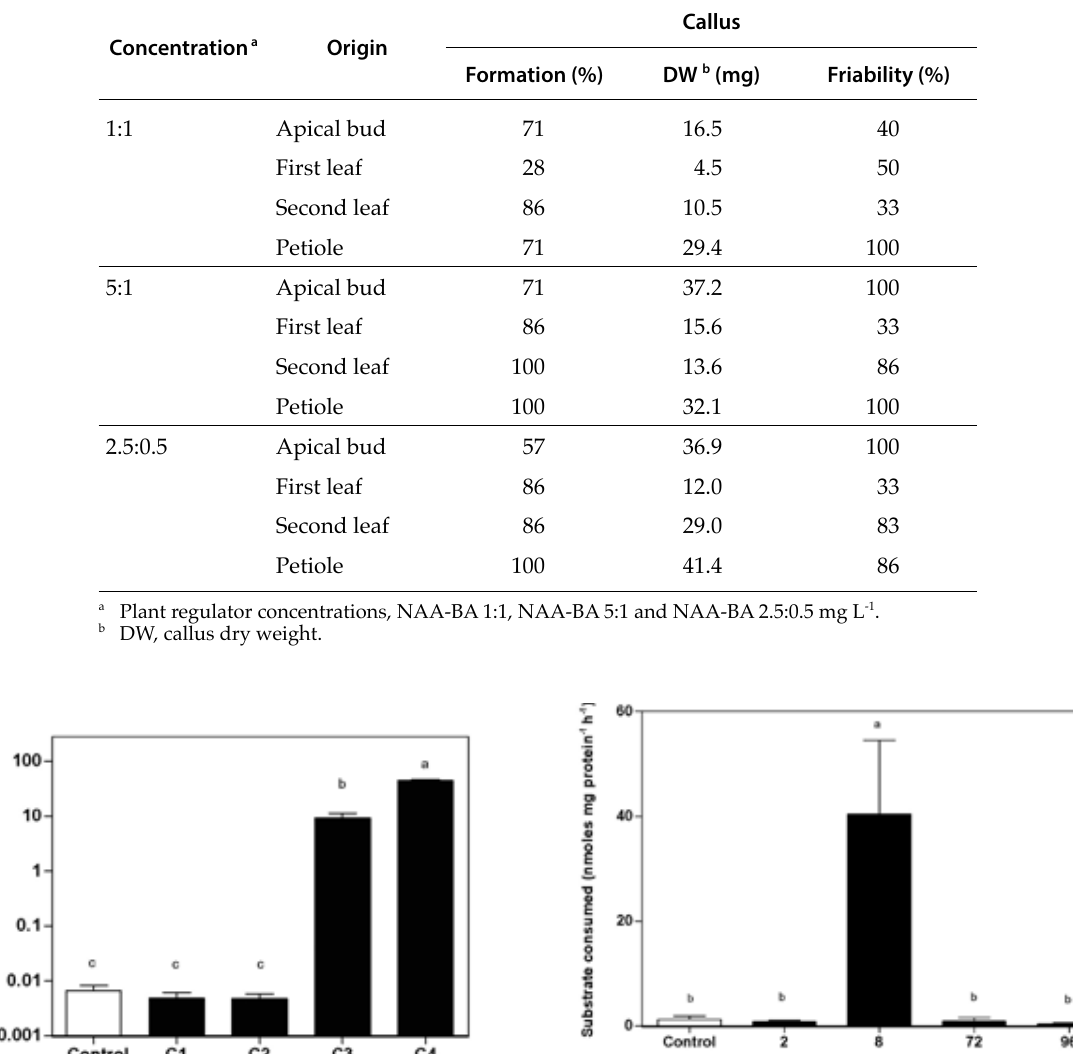
Table 1. Calluses formation from apical buds, first and second leaf, and petiole, in three combinations of plant regulator concentrations, NAA-BA 1:1, NAA-BA 5:1 and NAA-BA 2.5:0.5 mg L -1 . Concentration a